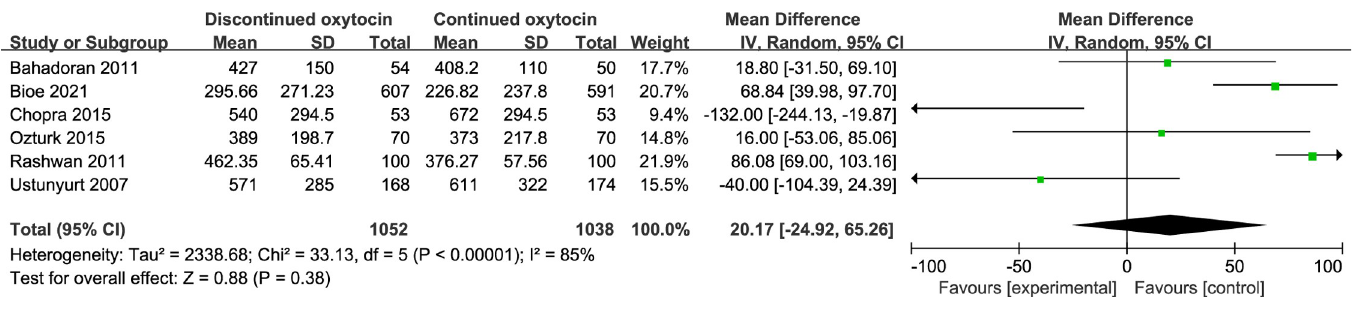
Fig 13. Pooled results for each